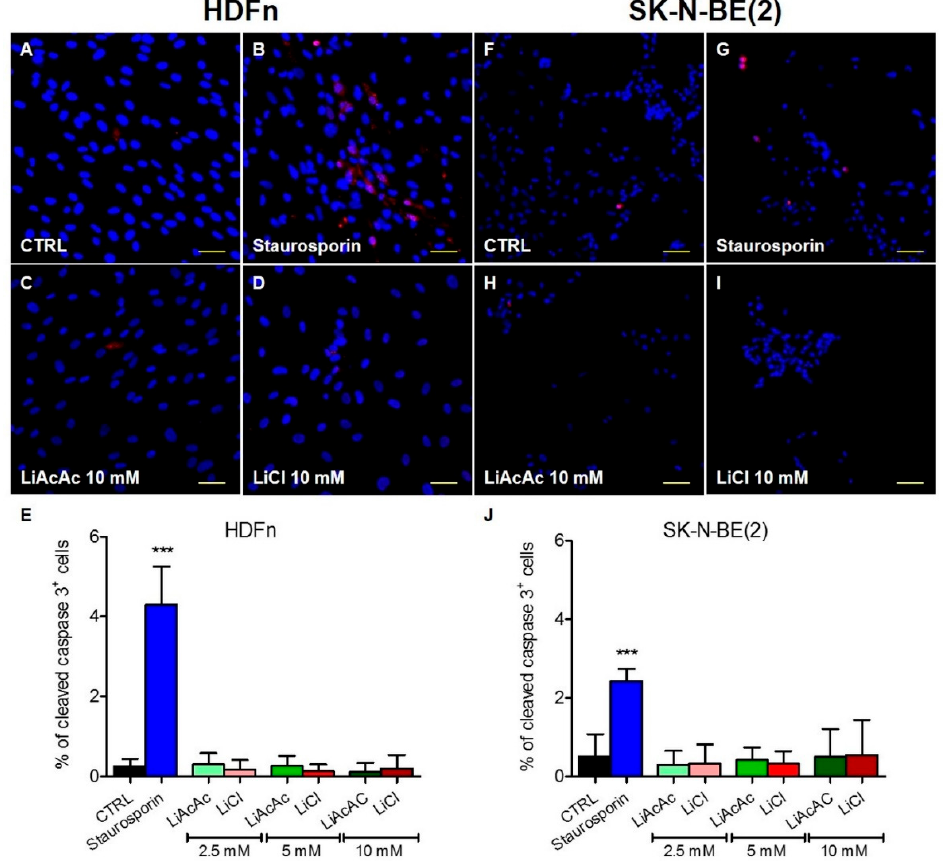
Figure 3. Immunofluorescence staining of cleaved caspase 3 (red): HDFn ( A – D ) and SK-N-BE(2) ( F – I ) cells were treated with 2.5, 5, and 10 mM LiAcAc ( C , H ) or equimolar concentrations of LiCl ( D , I ) for 5 days. As positive control, cells were treated for 3 hours with staurosporin 1 µ M ( B , G ). Nuclei are demarcated with DAPI (blue). Scale bar: 50 µ M. Figure 3 ( E , J ) shows the percentage of cleaved caspase 3 positive HDFn ( E ) and SK-N-BE(2) ( J ) cells. Data are given as mean ± SD. A statistical analysis was performed by using one-way ANOVA (Dunnett’s Multiple Comparison Test); data are compared to untreated control cells: *** p < 0.001; n = 9–10 macroscopic fields.